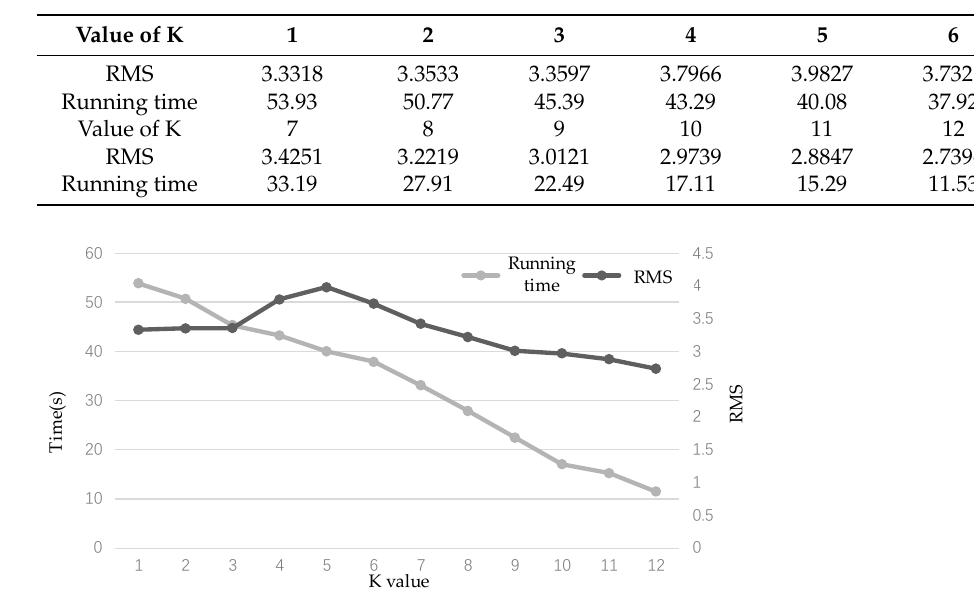
Table 2. Comparative analysis of depth estimation based on geometric constraints.